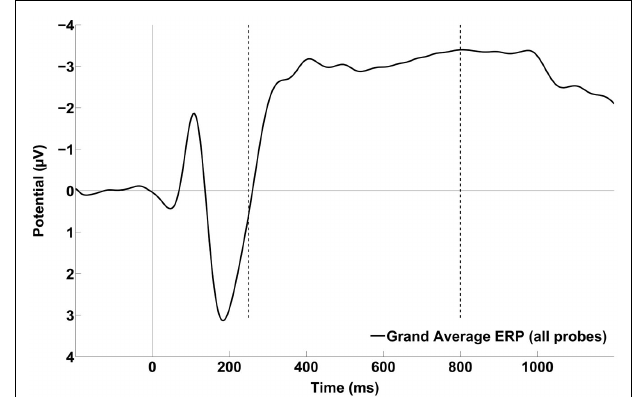
FIGURE 3 | Grand average of the ERP waveforms obtained by collapsing across the six frontal and central electrodes of interest (i.e., FCz, FC1, FC2, C1, C2, and Cz) time-locked to stimulus onset and including trials from all probe durations. Vertical dotted lines indicate the